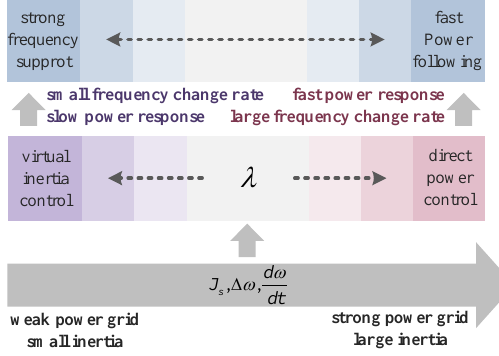
Figure 9. Active power and frequency characteristics of VVSG with participation factor of direct power control λ varies.